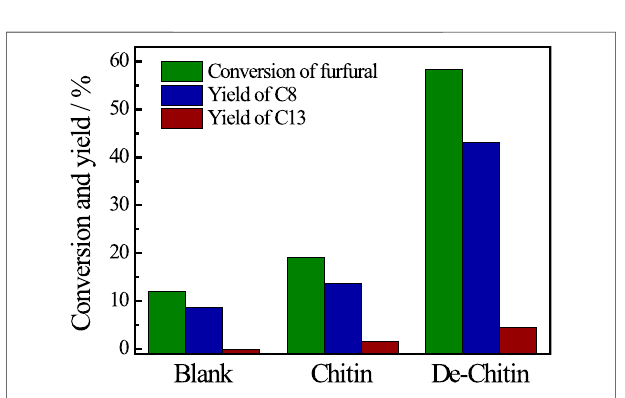
FIGURE 4 | Aldol reaction catalyzed by various catalysts. Reaction conditions: furfural 0.48 g, acetone 1.16 g, catalyst 0.1g, 140 ° C, 4 h.